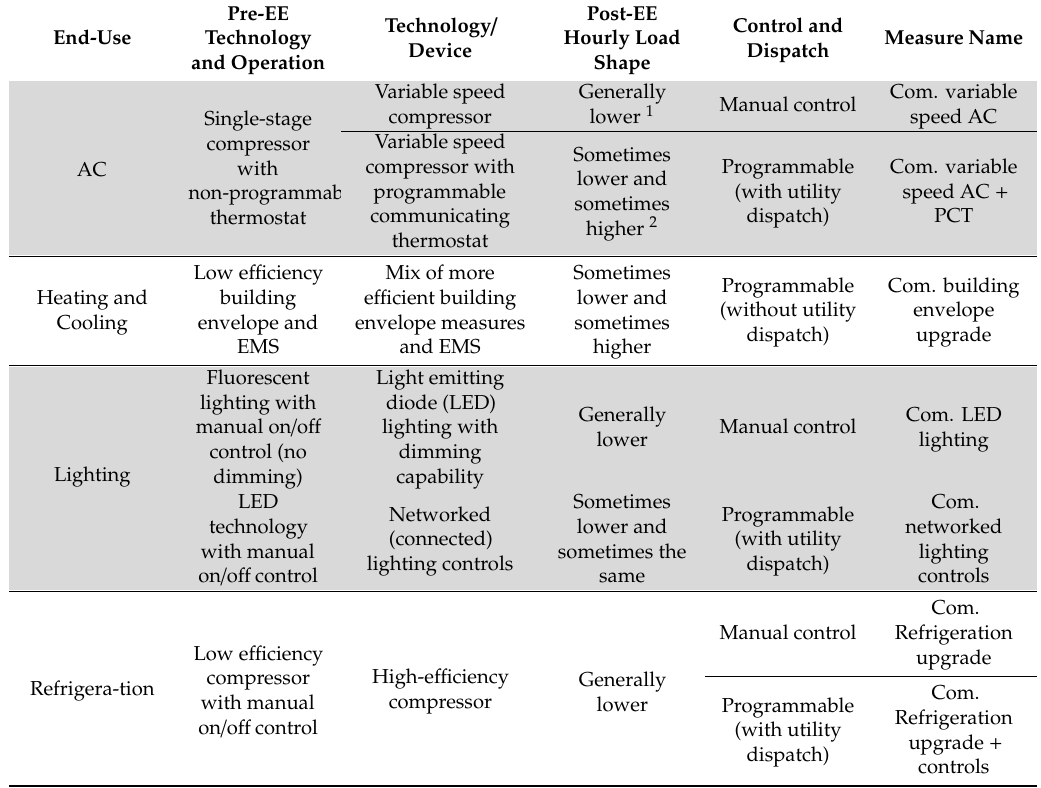
Table 3. Example commercial measure definitions.